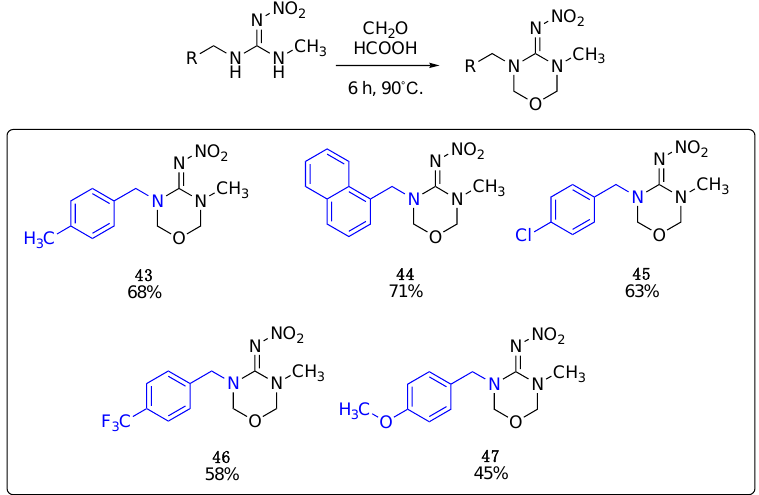
Scheme 7. N -methylated cyclic